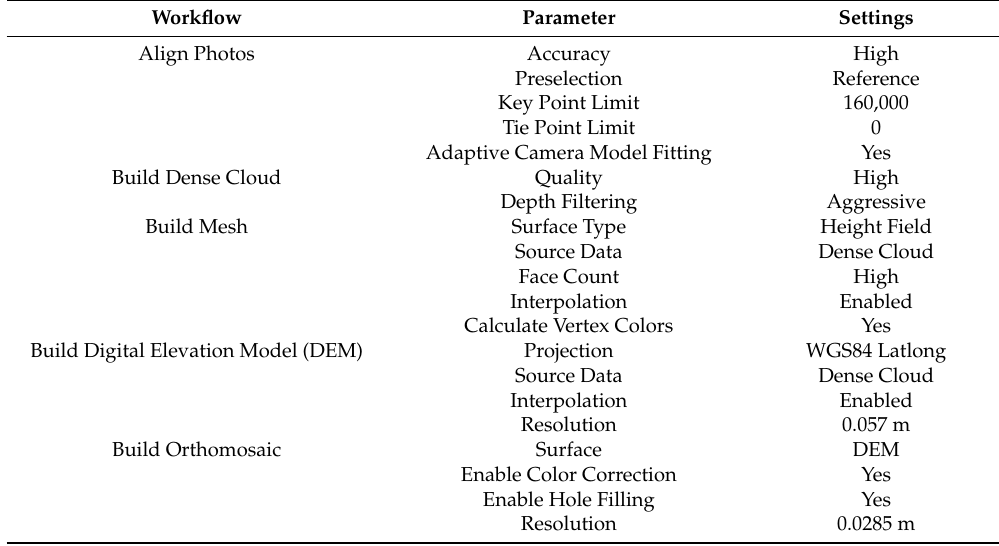
Table 1. Parameter settings for the workflow for generating 3D models (PhotoScan